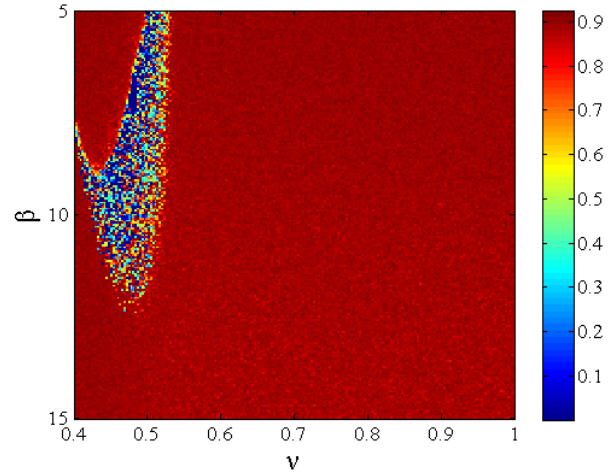
Figure 9. SE of the fractional-order map with regard to ν and β .